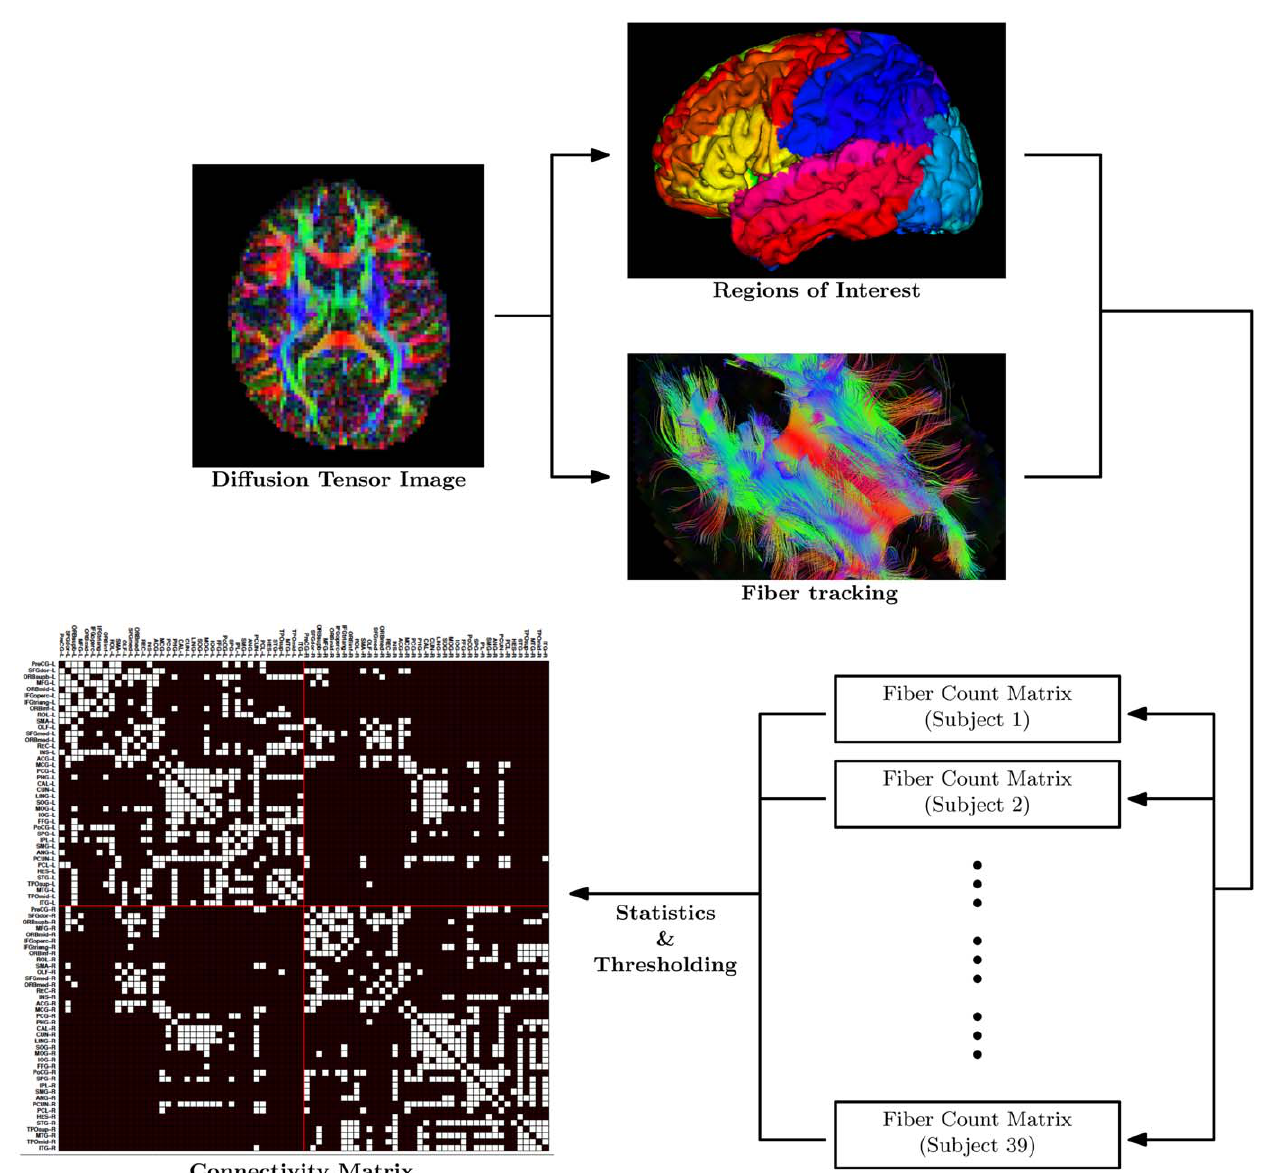
Figure 1. Obtaining the Connectivity Matrix. A schematic digram illustrating the major processes involved in generating the final connectivity maps. Streamline fiber tractography was performed on each diffusion tensor image and a connectivity matrix was computed based on the AAL [23] ROIs. The fiber count matrices were constructed by enumerating the number of fibers connecting each region pair. The connectivity matrix, indicating consistent connections, was generated by thresholding the fiber count statistics.